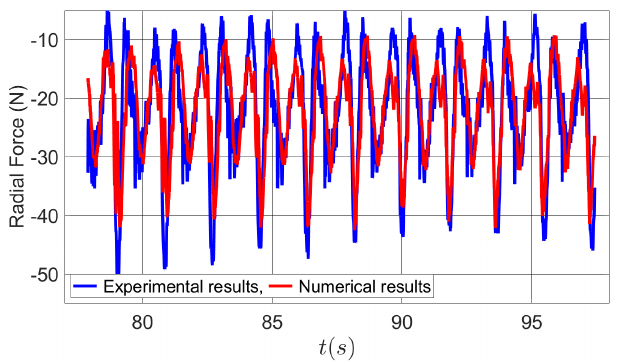
Fig. 4. Comparison of the experimental and numerical values of the radial force